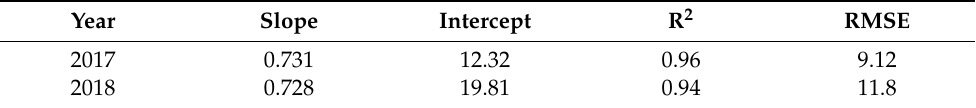
Table 5. Linear regression statistics for fruit count using the Xception_count model against the MangoYOLO model for tree images for orchard A (988 images of 494 trees) for 2 seasons. Units for intercept and RMSE are #